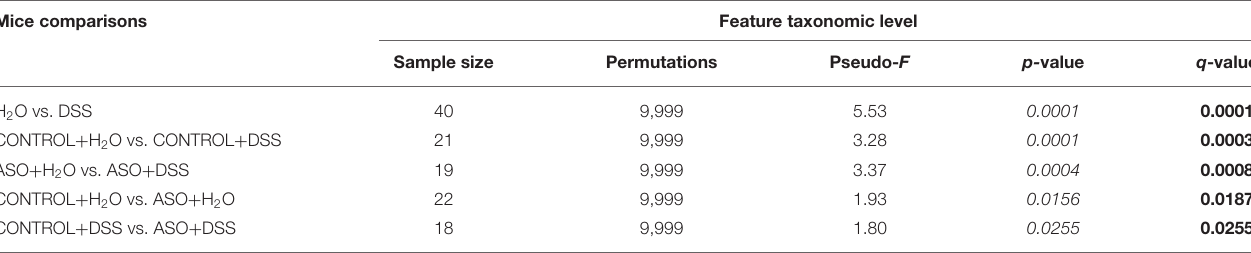
TABLE 1 | Significant differences in intestinal microbial community structures were observed between mice groups in beta diversity analyses conducted on microbial features. Mice